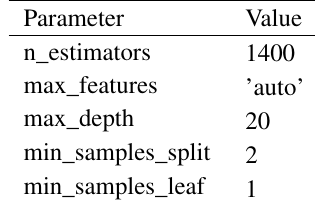
Table 6 Optimal parameter combination